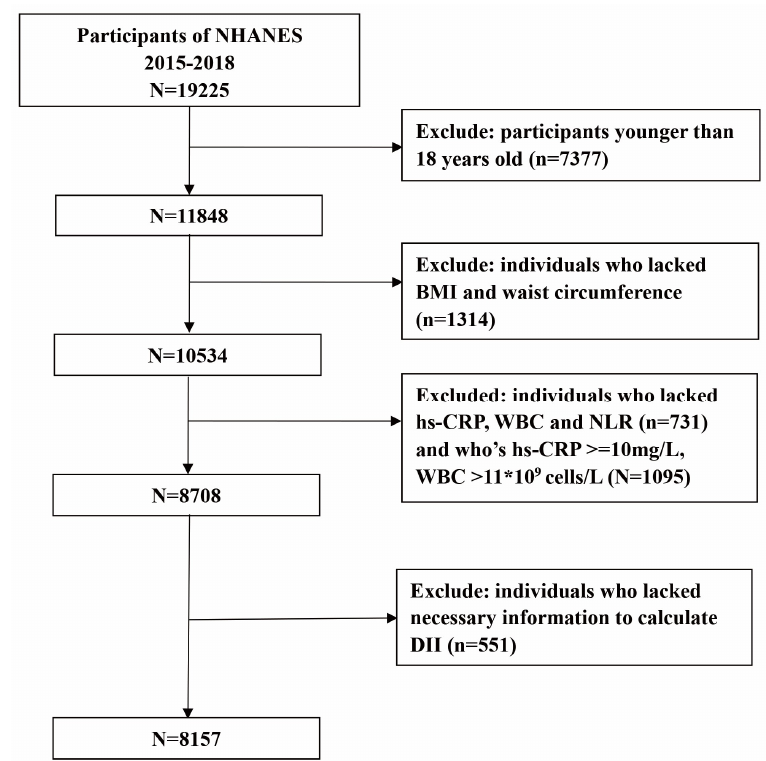
Figure 1. Flow chart of the screening process for the selection of eligible participants.